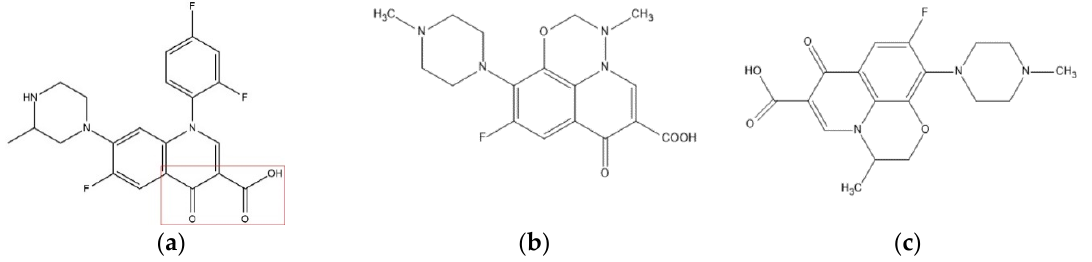
Figure 1. ( a ) Molecular structure and common skeleton of Temafloxacin; ( b ) molecular structure of marbofloxacin; ( c ) molecular structure of levofloxacin.